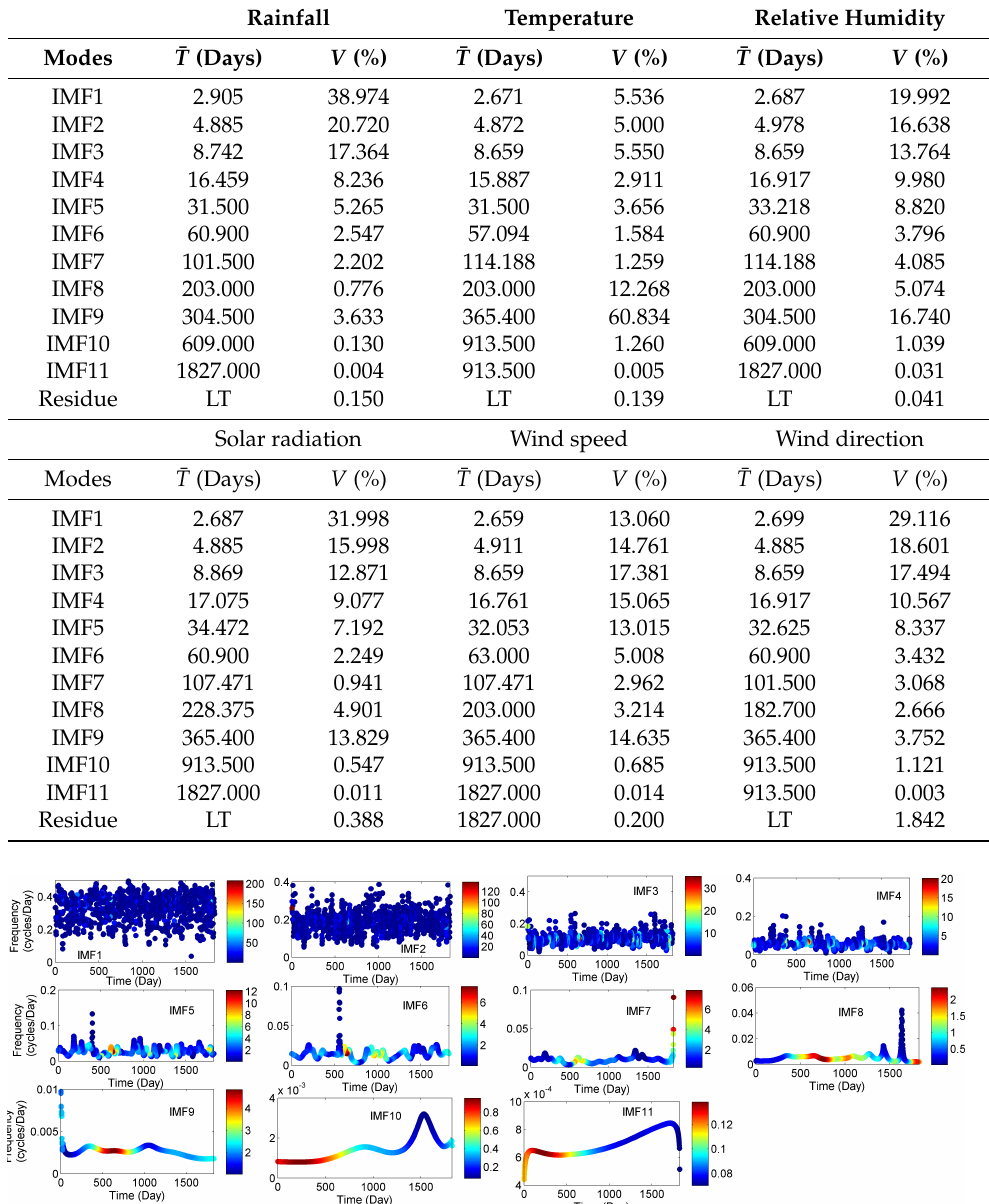
Table 1. Periodicity ( ¯ T ) and variability ( V ) obtained by the MEMD analysis for all parameters. LT is for long term.